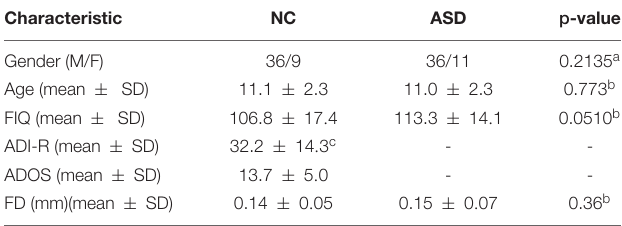
TABLE 1 | Demographic information of the